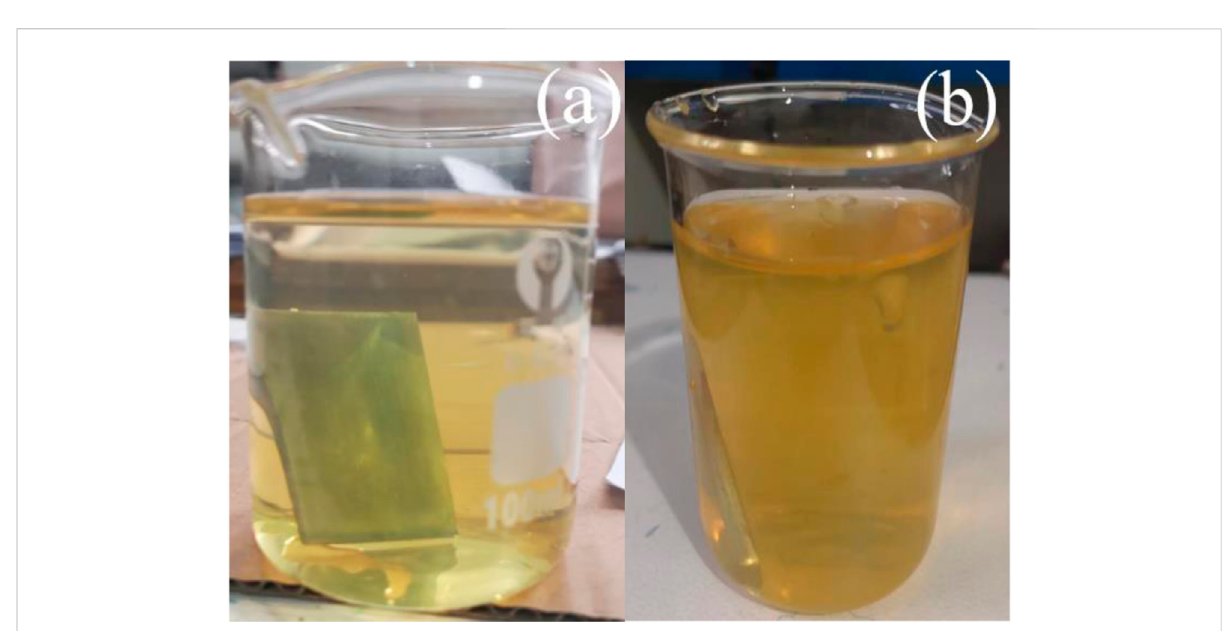
FIGURE 1 Two different colors of cerium conversion coatings at (A) 50 ° C and (B) 70 ° C temperature baths.